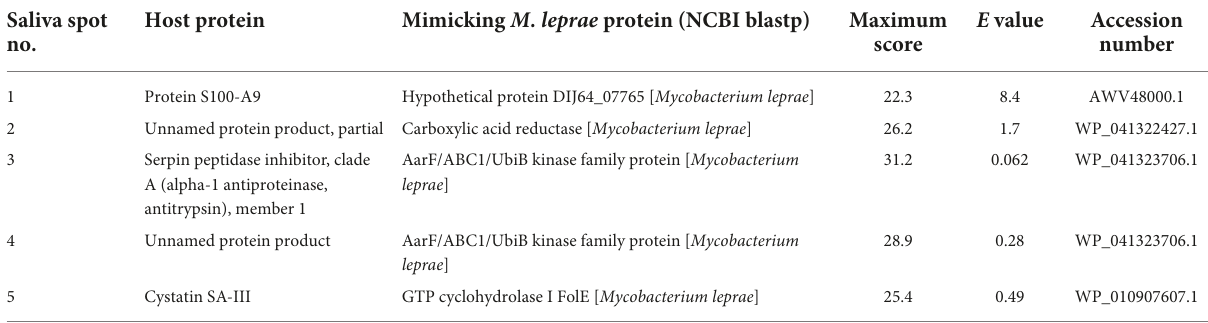
TABLE 4 The mimicking salivary proteins of the host homologous to Mycobacterium leprae proteins. Saliva spot no.